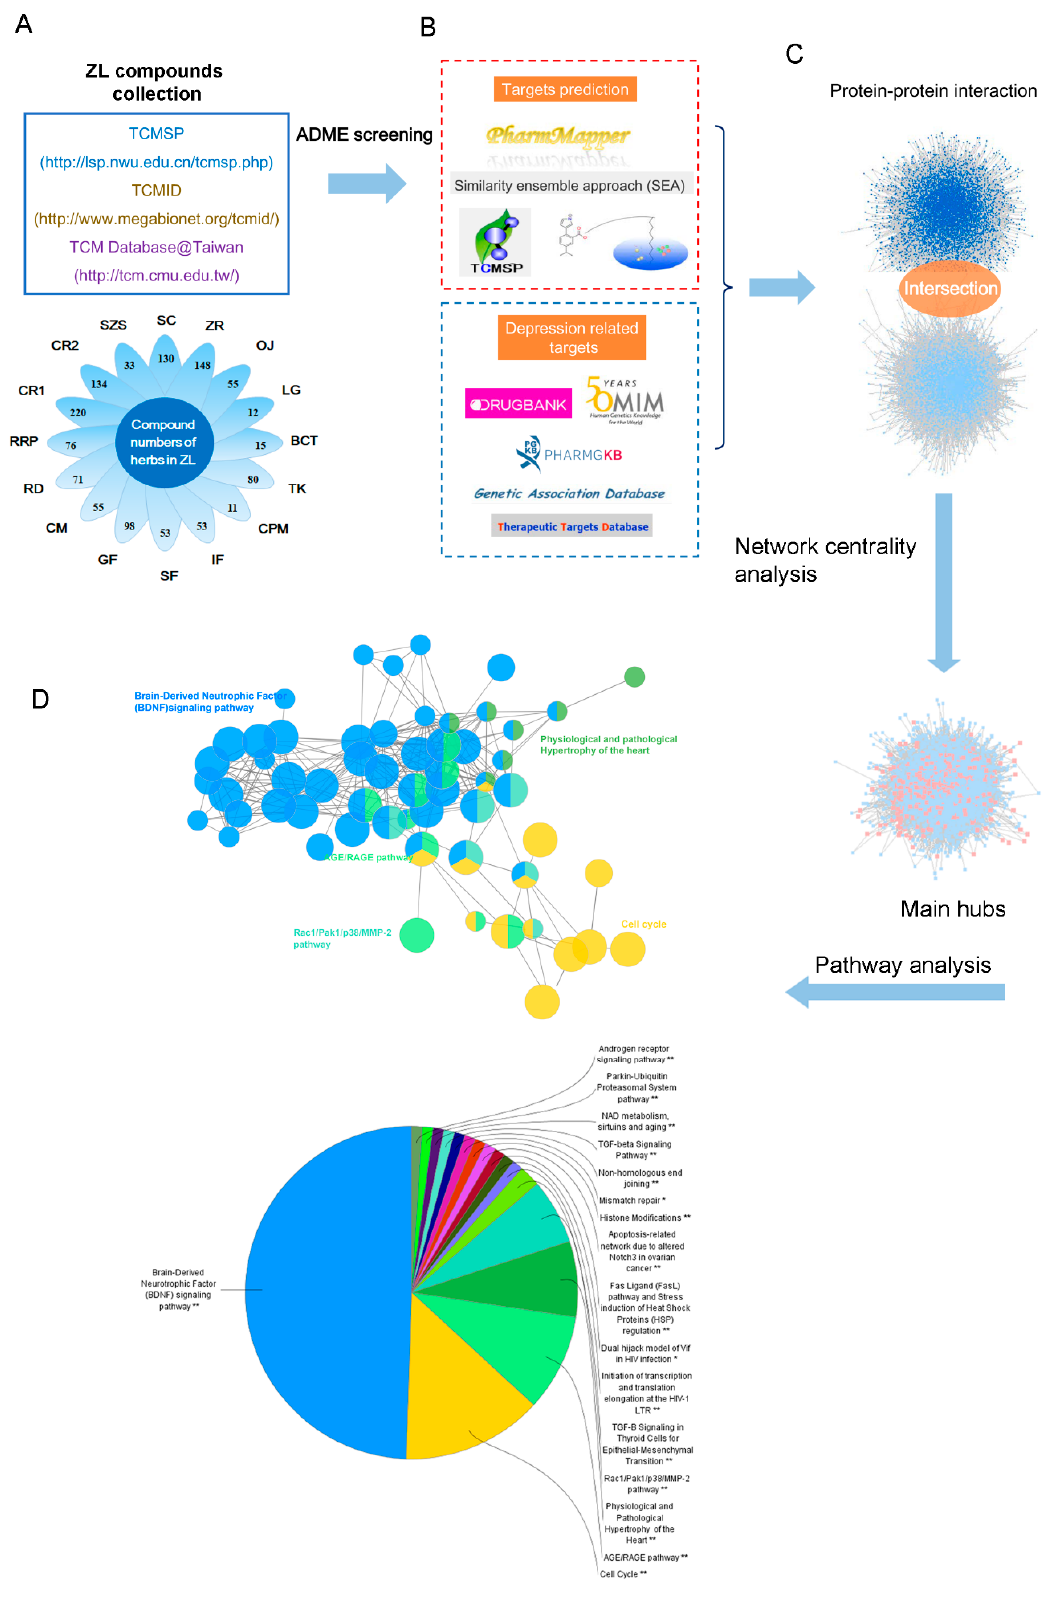
Figure 3. Systems pharmacology workflow. ( A ) Collection and screening of compounds from ZL; ( B ) active compound-target prediction and construction of known depression-related targets; ( C ) identification of therapeutic targets for ZL; ( D ) pathway enrichment